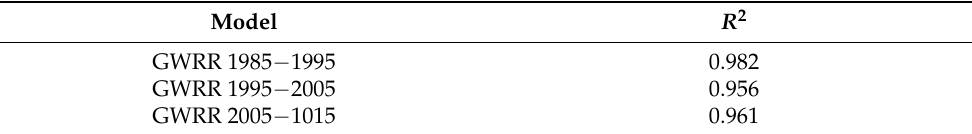
Table 6. Model Results of GWRR.